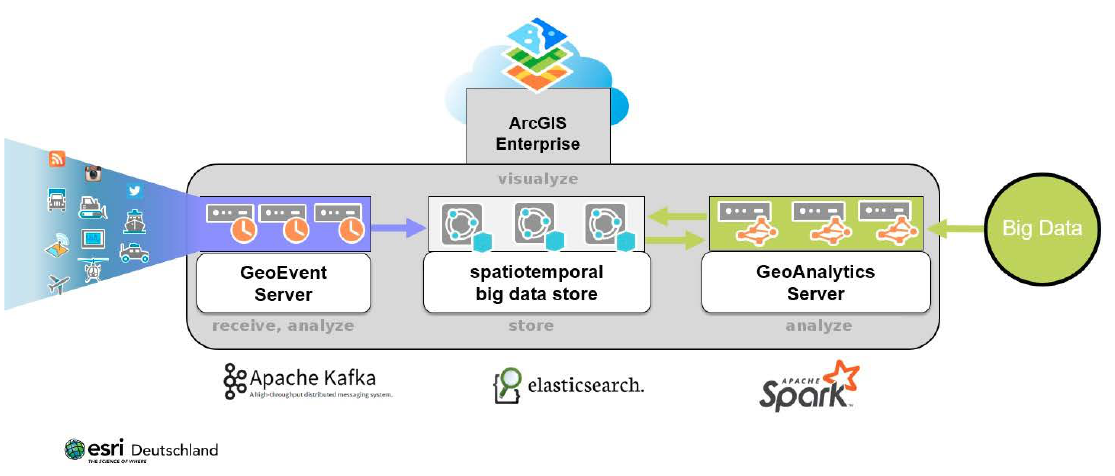
Figure 2. Overview of ESRI Spatio-temporal Data Streaming